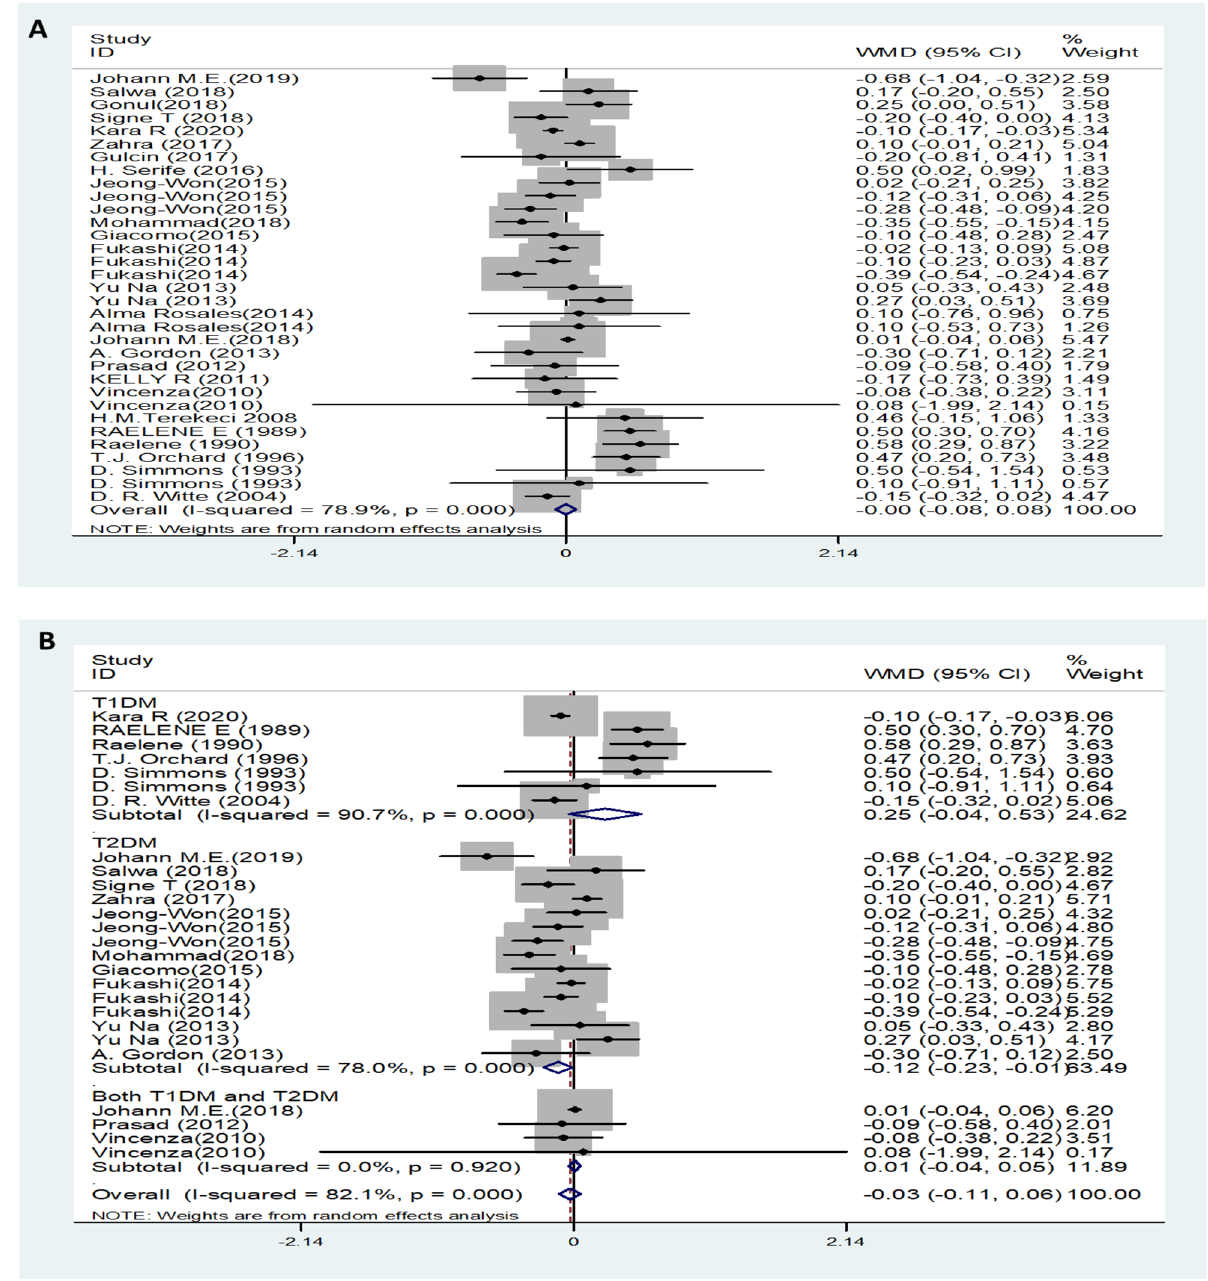
Figure 5. LDL levels ( A ) in people with DN versus those without DN. LDL levels in the subgroup analysis stratified by the type of diabetes ( B ) and symptom severity ( C ). OR ( D ) for DN in patients according to serum LDL